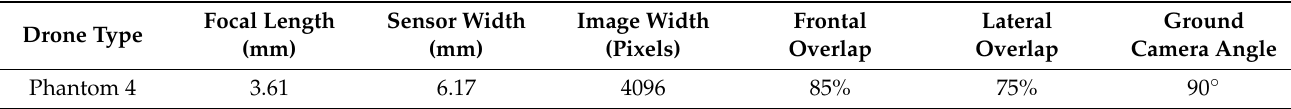
Table 2. Camera and mission